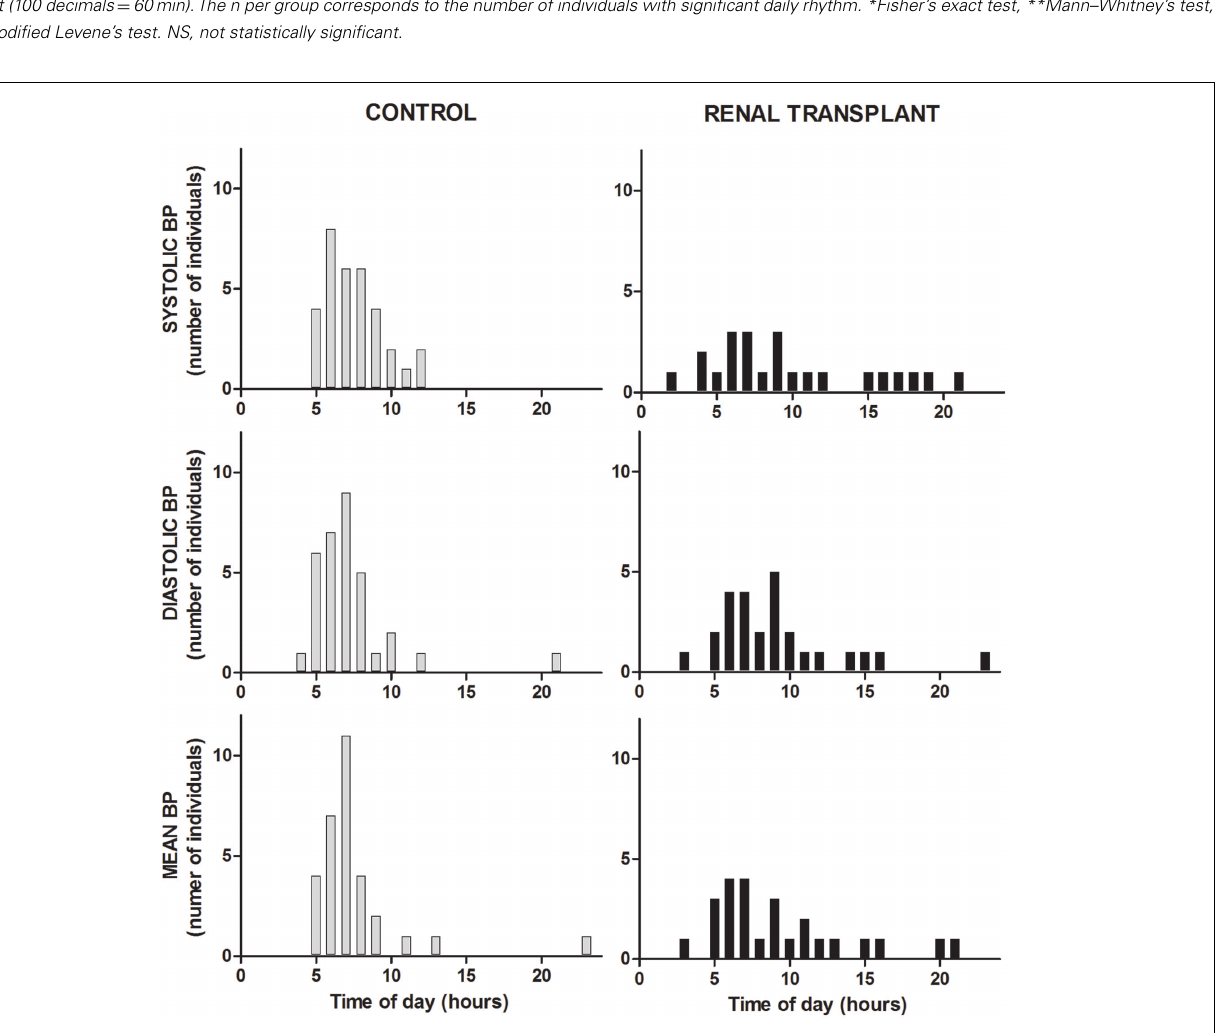
FIGURE 2 | Histograms showing the distribution of the times when transition from low to high blood pressure stages occur for SAP, DAP, and MAP in renal transplant recipients and controls.